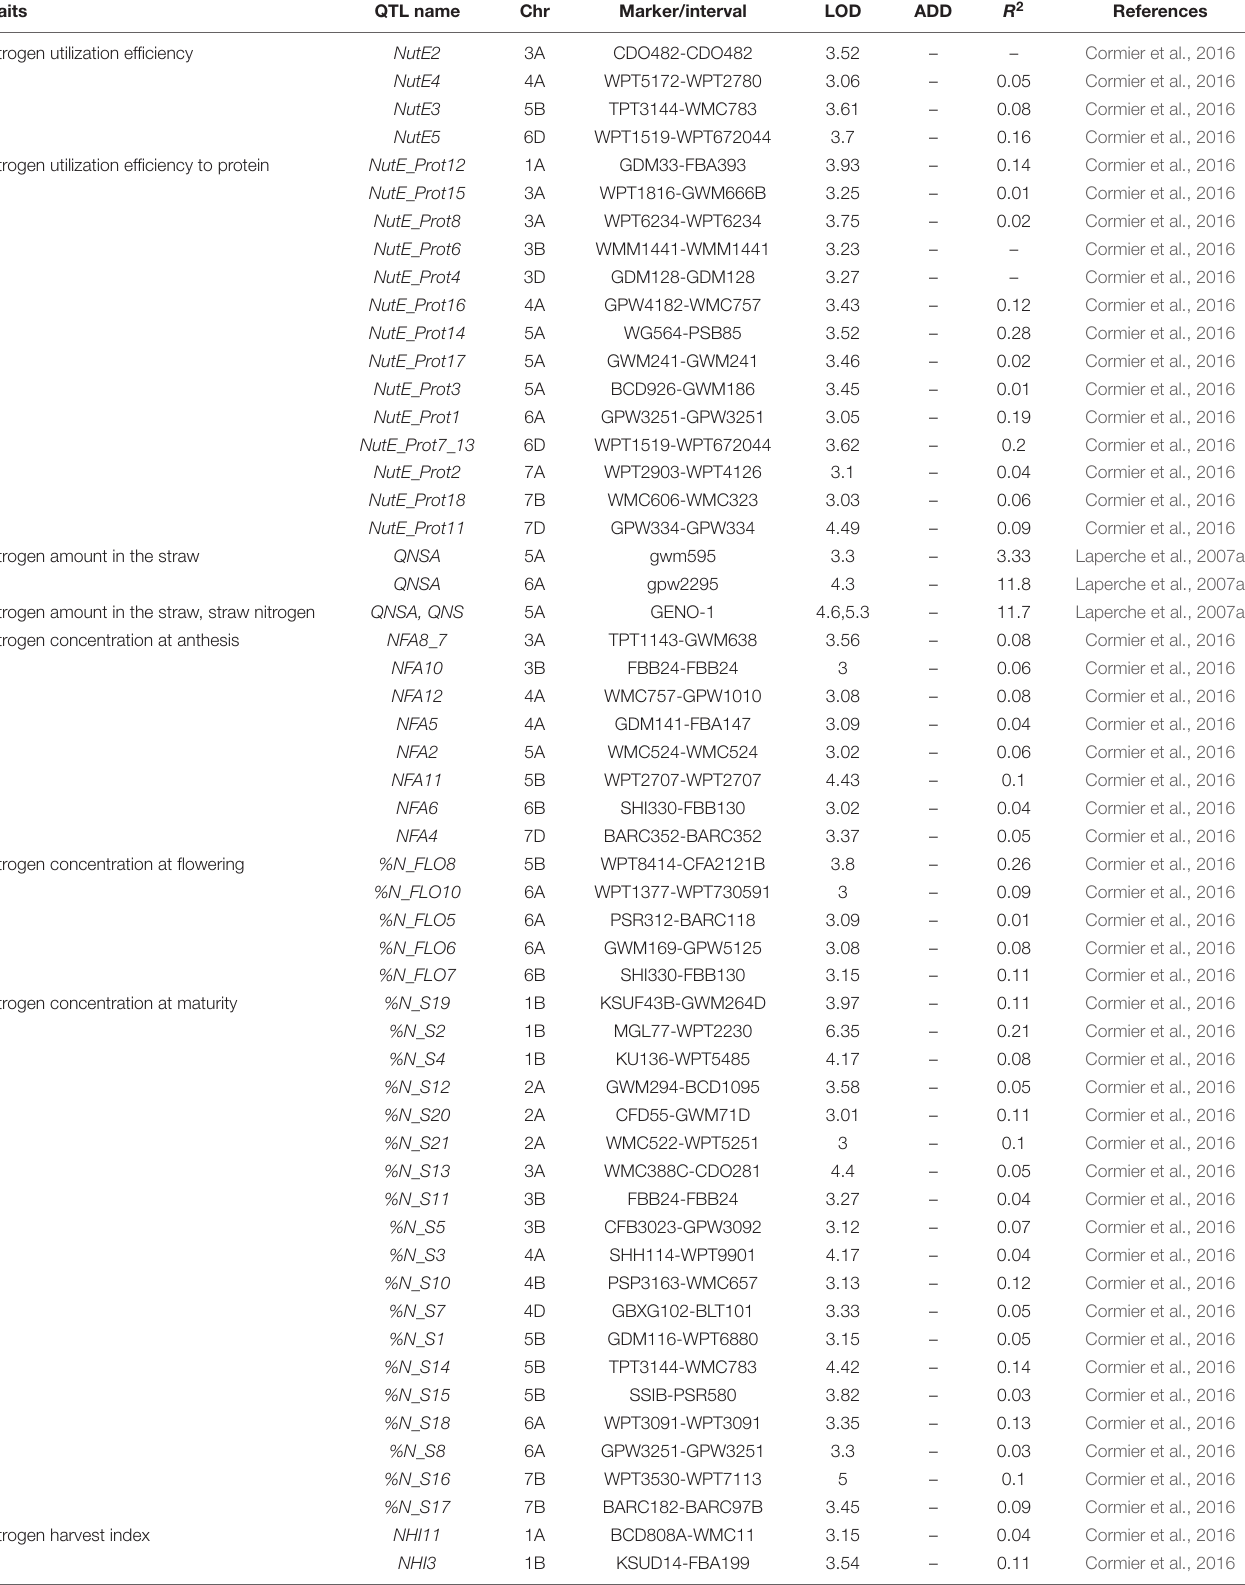
TABLE 4 | Detailed description of QTL associated with nitrogen use efficiency in